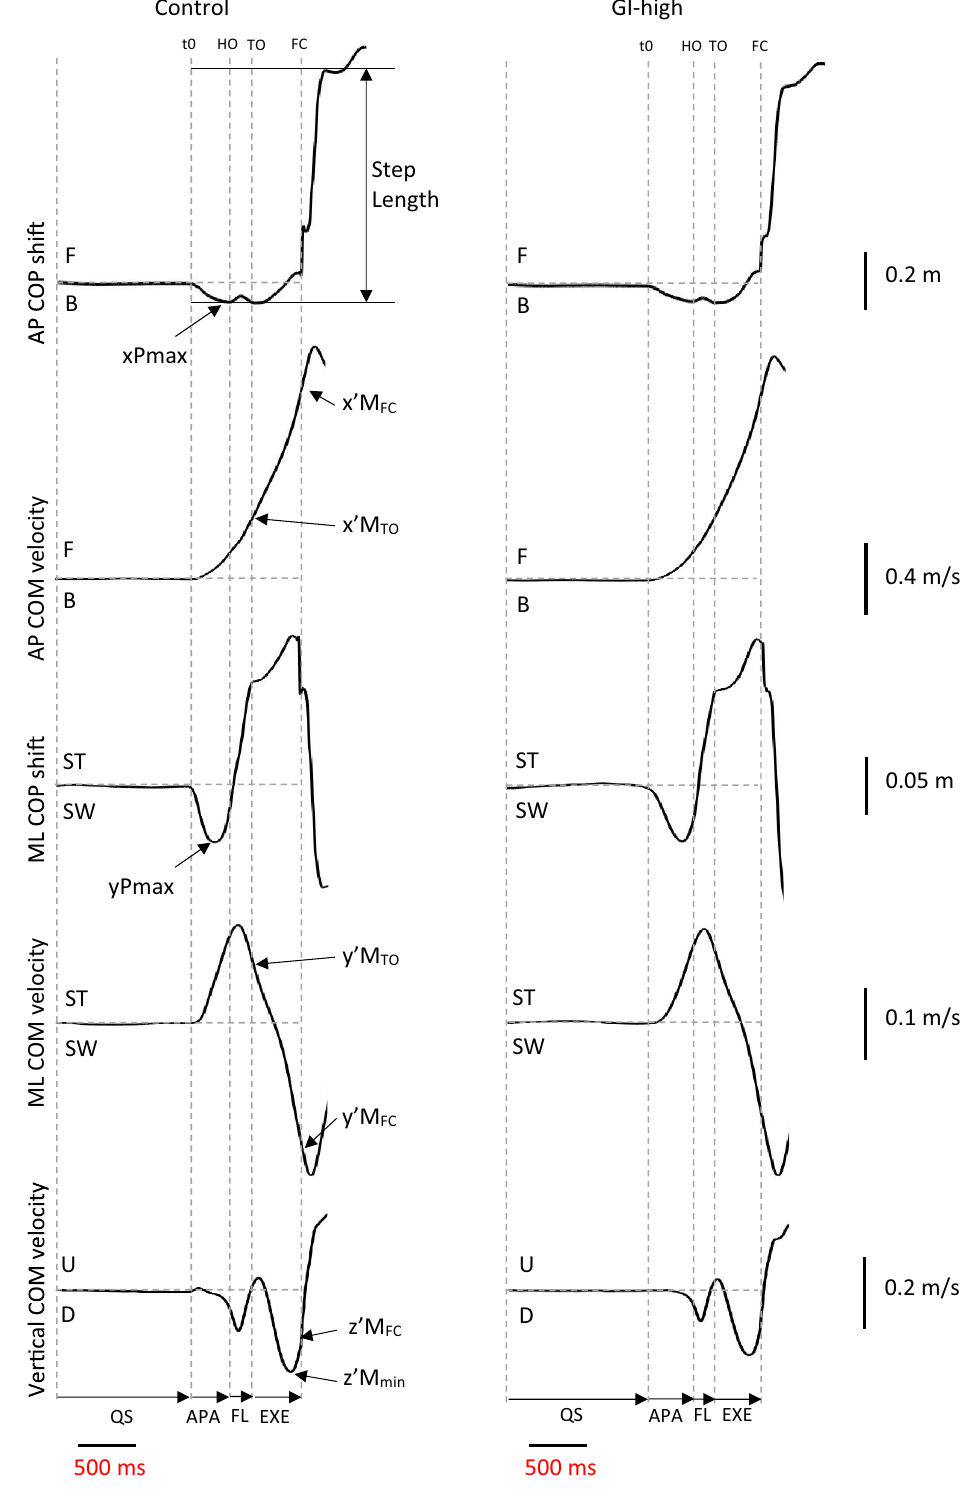
Figure 1. Typical biomechanical traces in the Control condition and the GI-high condition (gait initiation with a high level of cervical spine mobility restriction). Traces reported in each condition are obtained from the same participant performing one single trial. Anteroposterior (AP) direction . x’M TO , x’M FC : centre-of-mass (COM) velocity at toe-off and foot-contact. xPmax: peak of backward centre-of-pressure (COP) shift during APA. F forward; B backward. Mediolateral (ML) direction . y’M TO , y’M FC : COM velocity at toe-off and foot-contact. yPmax: peak of ML COP shift during APA. ST: stance limb; SW: swing limb. Vertical direction . z’M min , z’M FC : peak of negative vertical COM velocity and COM velocity at foot-contact. D downward; U upward. Vertical dashed lines: t0 onset variation of biomechanical traces; HO swing heel-off; TO swing toe-off, FC swing foot-contact. Horizontal arrows : QS quiet standing, APA anticipatory postural adjustments; FL: swing foot-lift; EXE execution phase of gait